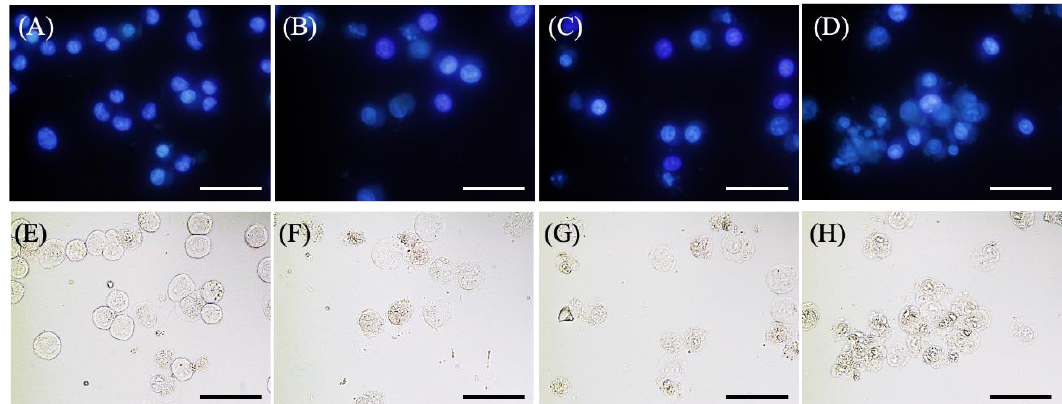
Figure 4. Morphological changes in EMT-6 cells 6 h after PDT with artesunate (ART) or artemether (ARM). EMT-6 cells were incubated with 1 mM 5-aminolevulinic acid (5-ALA) for 4 h prior to washing and exposure to a 635-nm LED light. Subsequently, cells were incubated for an additional 6 h before Hoechst 33342 staining. The 5-ALA-PDT with ARM group had a marked increase in condensation of nuclear chromatin relative to the other groups. Images represent the ( A and E ) control, ( B and F) 5-ALA-PDT, ( C and G ) 5-ALA-PDT and ART, and ( D and H ) 5-ALA-PDT and ARM groups. Upper panel ( A – D ): Fluorescence images. Lower panel ( E – H ): Transmitted light images. Scale bar = 50 μm.